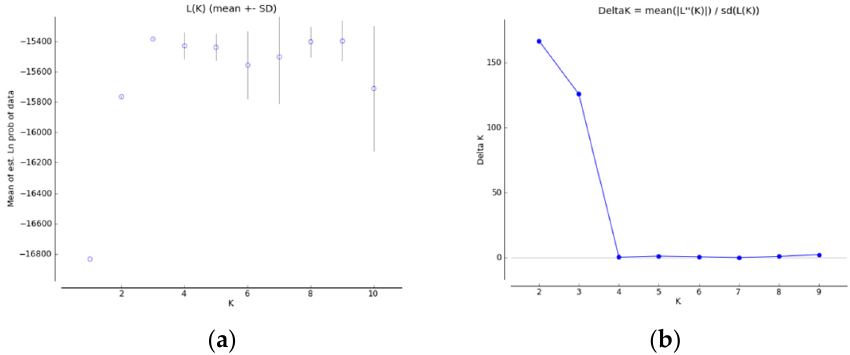
Figure 5. ( a ) Log-likelihood (L( K )) means for each number of cluster ( K ) from 10 independent runs in Structure Harvester (error bars represent SD). ( b ) graph shows Δ K for each K based on the first and second-order rates of change.